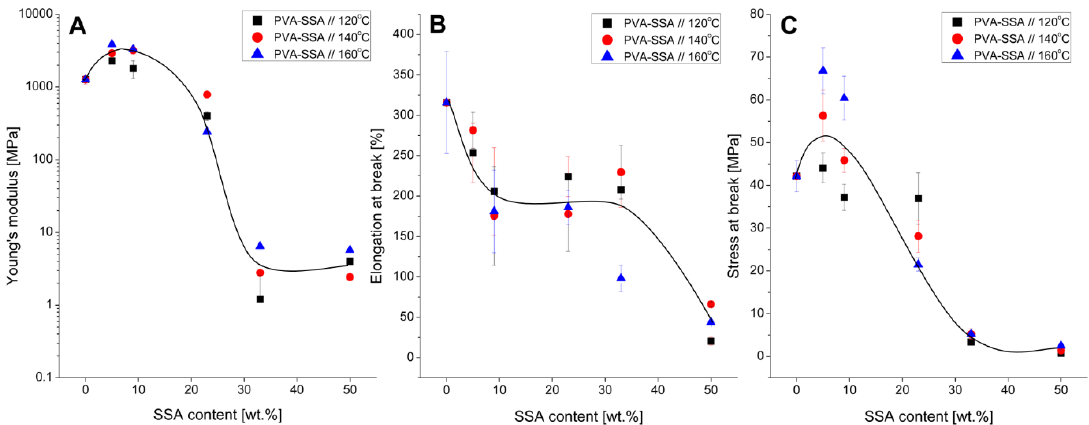
Figure 4. Influence of the crosslinking temperature on the mechanical properties of the PVA-SSA membranes: ( A ) Young’s modulus, ( B ) elongation at break, and ( C ) stress at break. The solid lines are only eye guided.